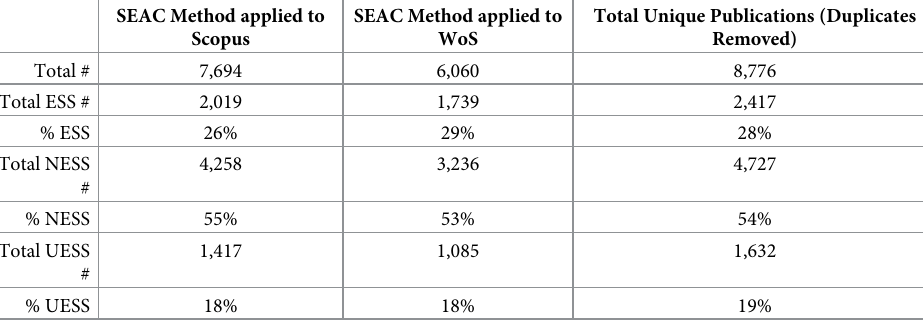
Table 9 shows the results of the SEAC method applied to the Scopus and WoS agroecology searches. The top rows (total and ESS) are comparable to the top rows (total and SS) of Table 8. Table 8 shows that the SEAC method identified 25% of all agroecological literature in our database as ESS, while Scopus and WoS identified SS publications as 18% and 19%, respec- tively, of their databases. When we use the SEAC method on just the Scopus and WoS Table 9. Results of the SEAC method applied to scopus and WoS. SEAC Method applied to